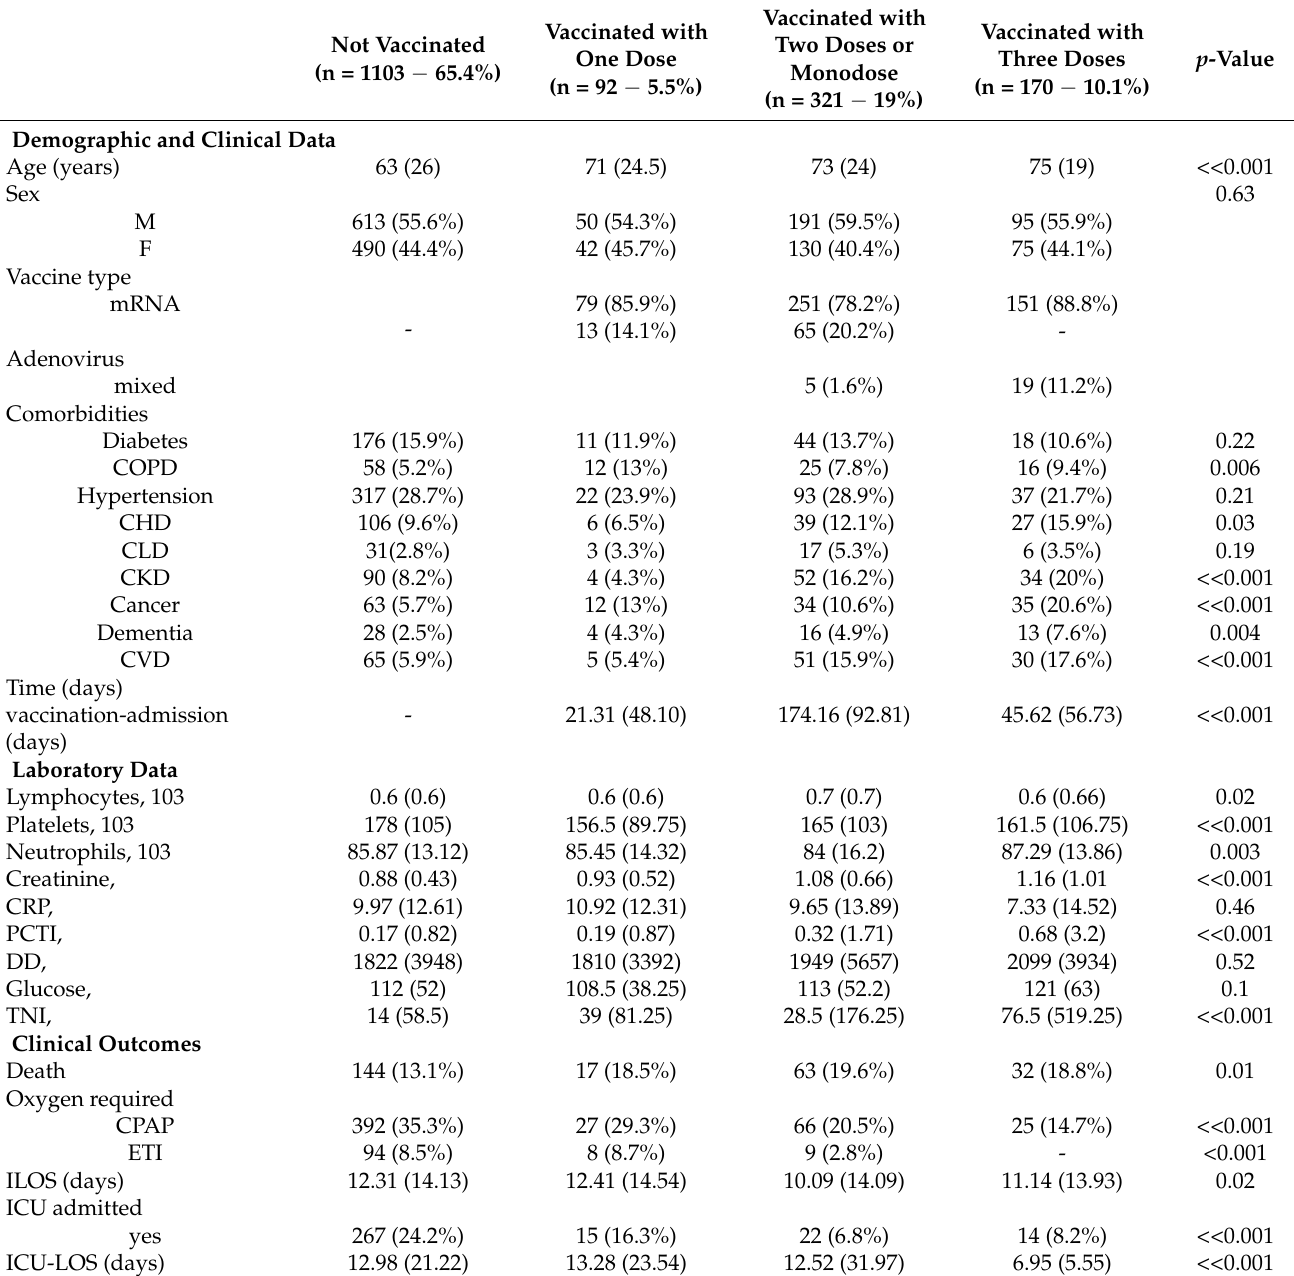
Table 1. General and clinical characteristics of 1666